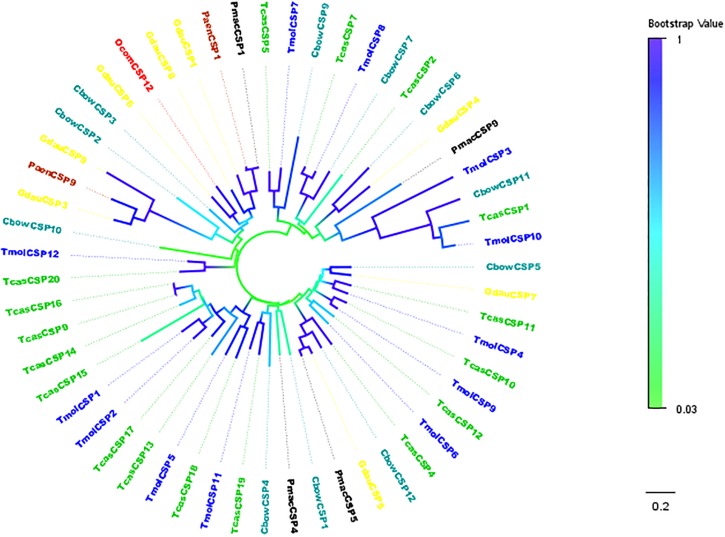
Neighbor-joining phylogenetic tree of OcomCSP12 (in red) with known Coleopteran CSP sequences. Tcas, Tribolium castaneum (in green); Pmac, Pyrrhalta maculicollis (in black); Paen, Pyrrhalta aenescens (in wine); Gdua, Galeruca daurica (in yellow); Cbow, Colaphellus bowringi (in dark cyan); Tmol, Tenebrio molitor (in blue).